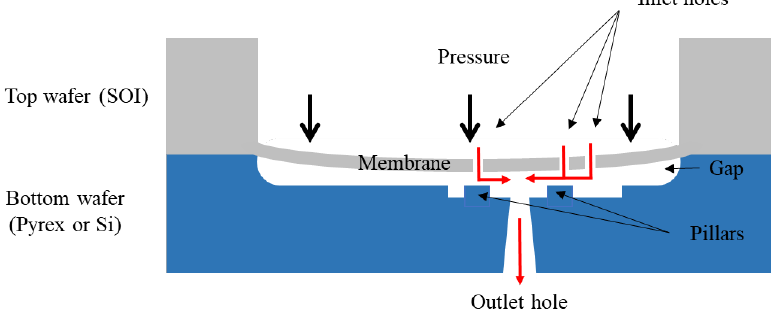
Figure 5. Cross-section of a passive flow regulator with a top SOI wafer (membrane) and a bottom wafer (substrate) made of Pyrex or Si. The fluid flows through the inlet holes of the membrane, the radial diffuser (annular restriction between the membrane and the pillar), and the outlet hole of the substrate. As the pressure increases, the deflection of the membrane induces an increase in the hydraulic resistance of the radial diffuser to keep the flow rate constant. The flow direction is indicated by red arrows.